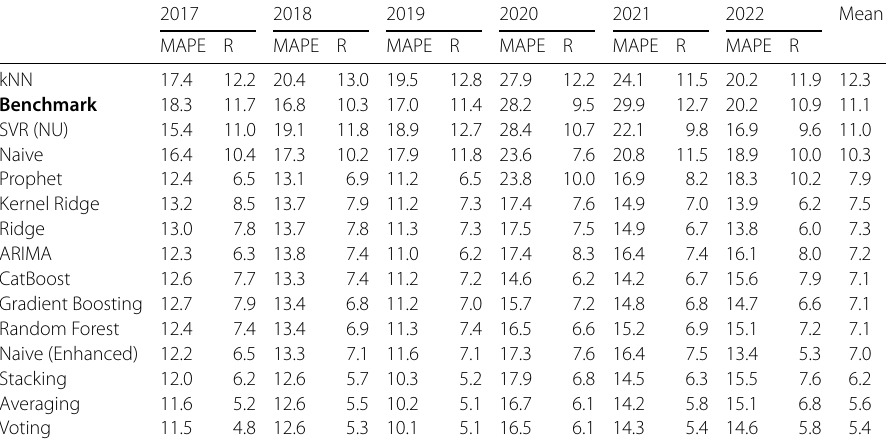
Table 6 Accuracies and mean ranks for all models across each year for Clinic